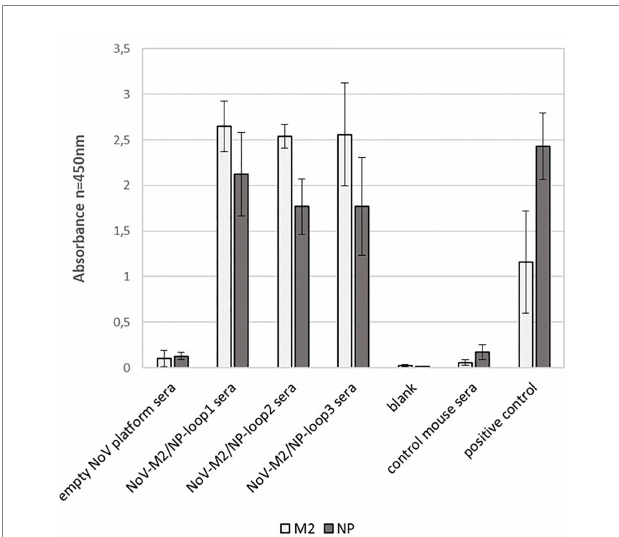
FIGURE 6 Analysis of the terminal antibody titers in the pooled mouse sera collected after immunization with chimeric NoV-M2/NP VLPs. ELISA plates were coated with M2 antigen-presenting VLPs (NoV VLP with M2/NP epitope in all three loops). The dilution factor of the pooled sera is shown on the x-axis. For each ELISA, the mean value from three independent experiments performed is presented. The mean A450 values and standard deviations are shown on the